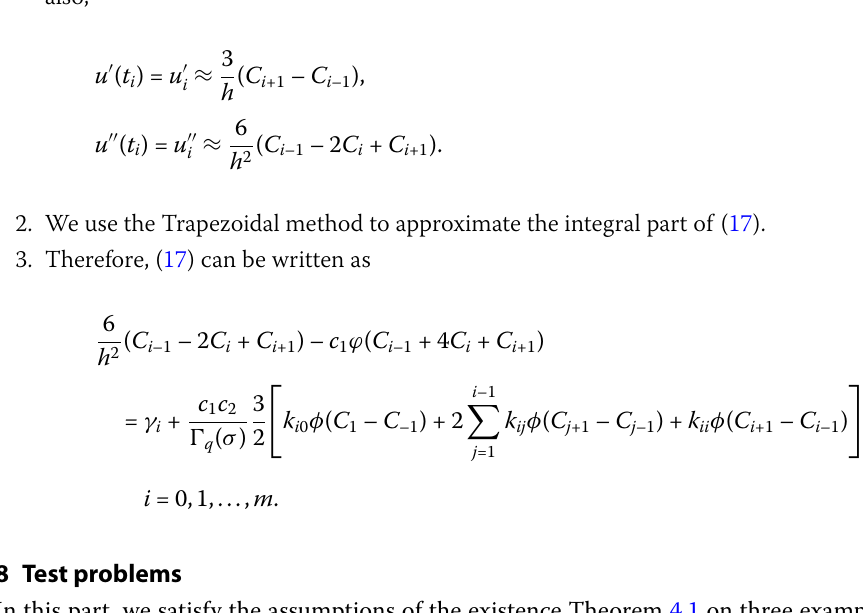
Table 1 The exact and numerical solutions of Test problem 1 t i Exact solutions Finite-Trap. Abs. error